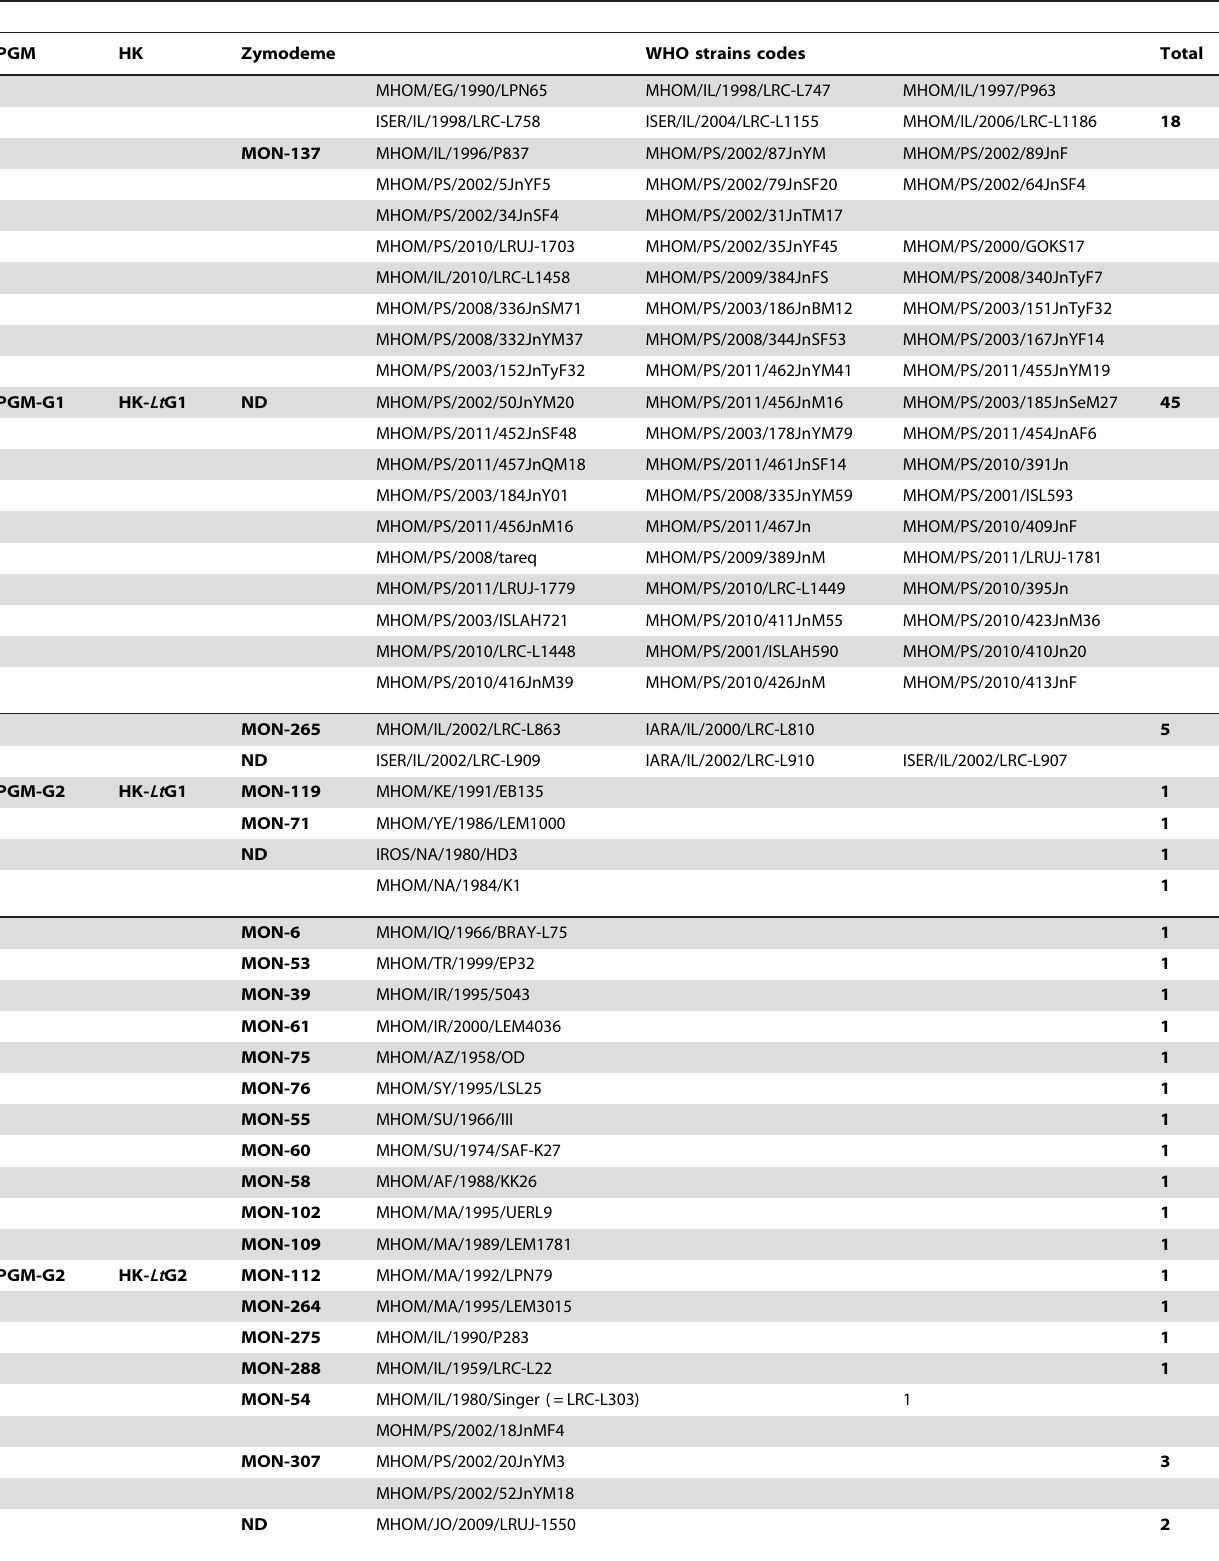
Table 1. The HK and PGM genotypes of the strains of Leishmania tropica studied, listed by their WHO codes, in which M stands for mammal, HOM Homo sapiens , PRO the hyrax genus Procavia , I insect, SER the sand fly species Phlebotomus sergenti , ARA the sand fly species Ph. arabicus , ROS the sand fly species Phlebotomus rossi , EG Egypt, IL Israel, PS Palestine, KE Kenya, YE Yemen,